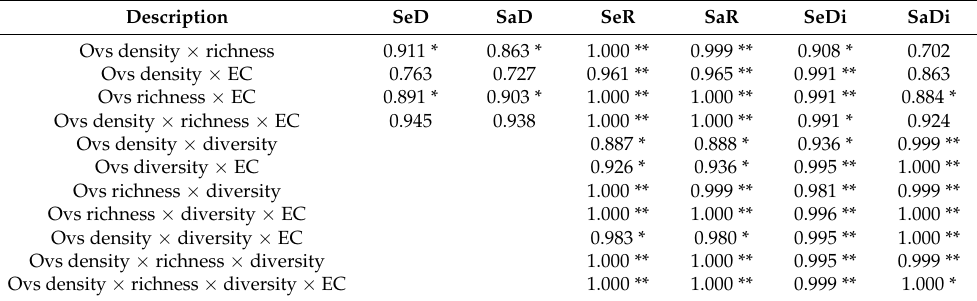
Table 10. Effects of overstory structural parameters on natural regeneration. Description